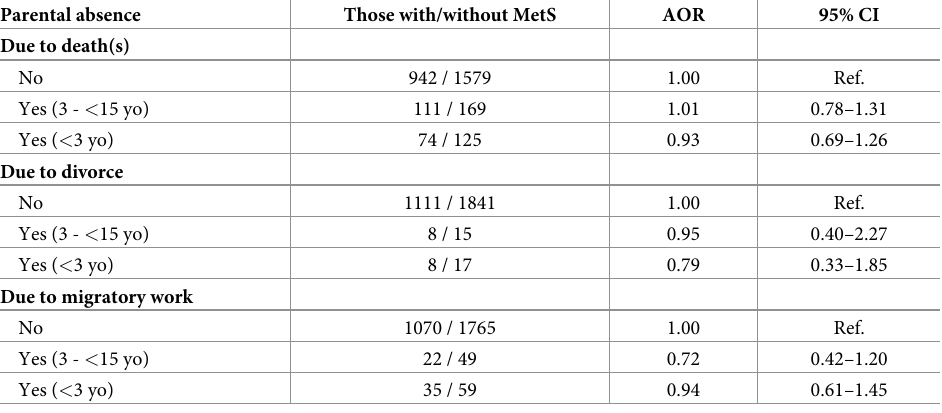
Table 3. Logistic regression analyses for the association between each cause of parental absence in childhood and metabolic syndrome in adulthood among study participants in the Khanh Hoa Cardiovascular Study, Vietnam (2019–2020).